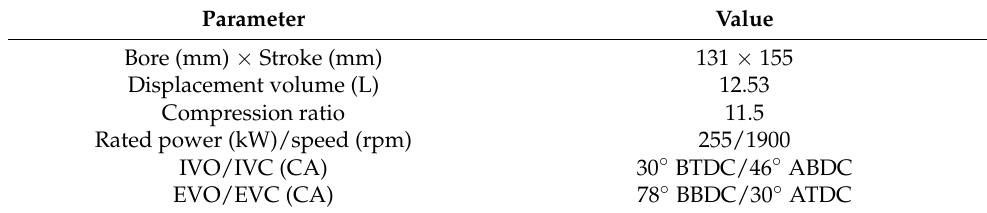
Table 1. Specifications of the